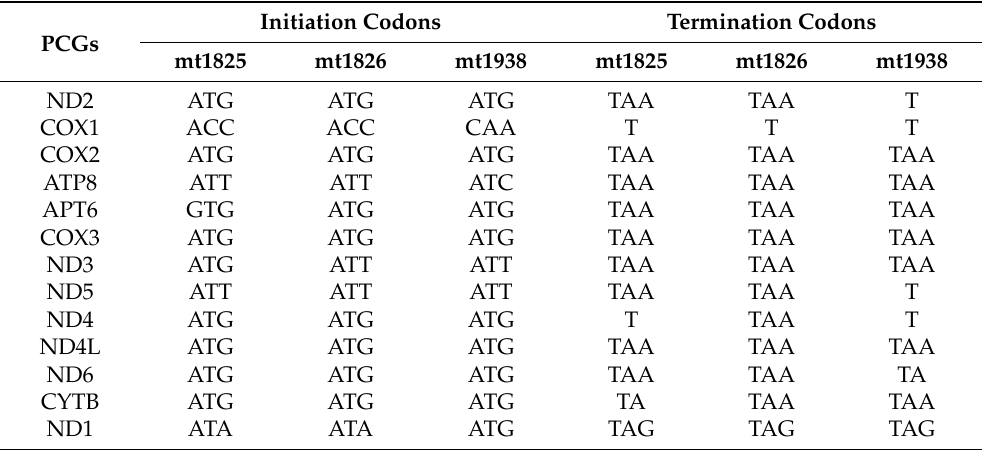
Table 2. Initiation and termination codons of protein coding genes (PCGs) of the newly sequenced complete mitogenomes.